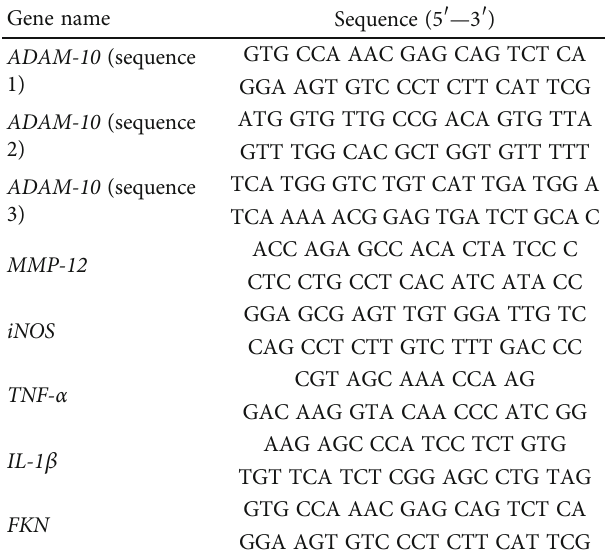
Table 1: Primer sequences used for gene ampli fi